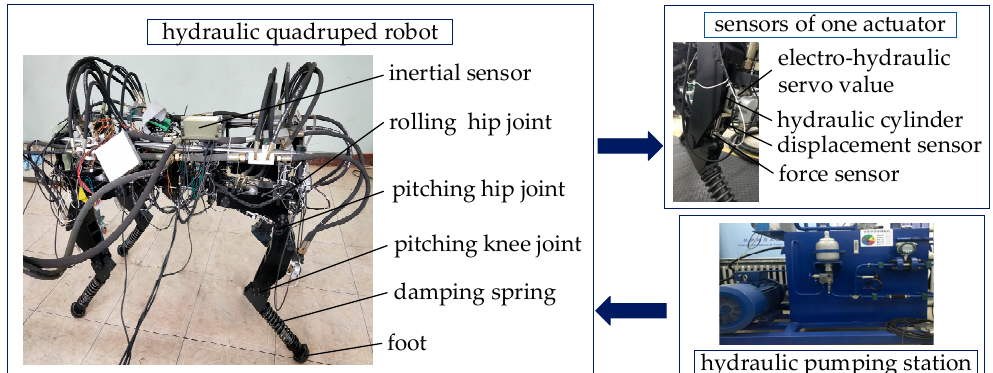
Figure 10. The test platform of hydraulic quadruped robot.